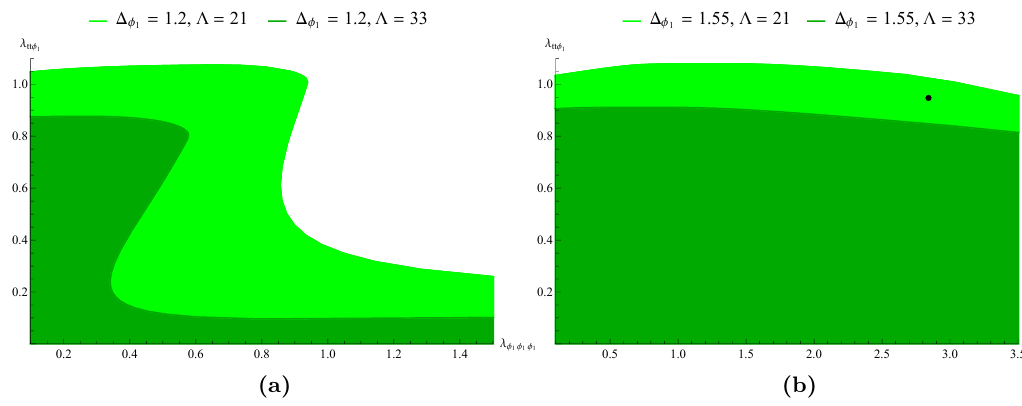
Figure 11. Bootstrapping the O(3) -breaking magnetic line defect. Upper bounds on the OPE coefficient λ φ as a function of λ . Λ = 21 , P = 41 and Λ = 33 , P = 63 . In (a) the external t ¯ tφ 1 1 φ 1 φ 1 scalar has dimension ∆ φ = 1 . 2 . In (b) the external scalar has dimension ∆ φ 1 expansion result is shown by the black